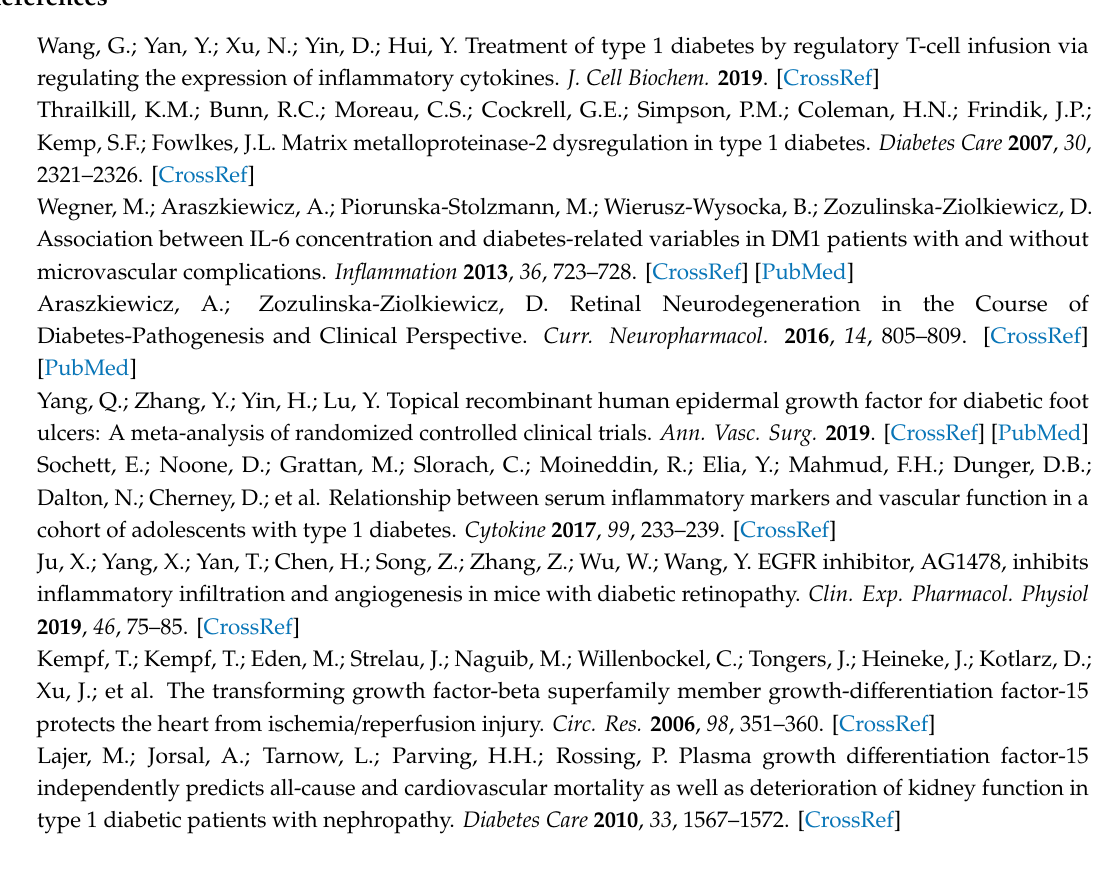
Supplementary Table S1. Characteristics of the study participants according to the presence of microangiopathy in the GDF-15 and MMP-2 cohort (number or median (IQR)), Supplementary Table S2. Characteristics of the study participants according to the presence of microangiopathy in the IL-29 cohort (number or median (IQR)), Supplementary Table S3. Correlations between various parameters and EGF concentration (Spearman’s rank correlation analysis), Supplementary Table S4. Markers of diabetic kidney disease occurrence in multivariate logistic regression analysis, with diabetic kidney disease as the dependent variable and GDF-15, T1DM duration, HbA 1c , smoking, and BMI as independent variables. For the entire model, p =